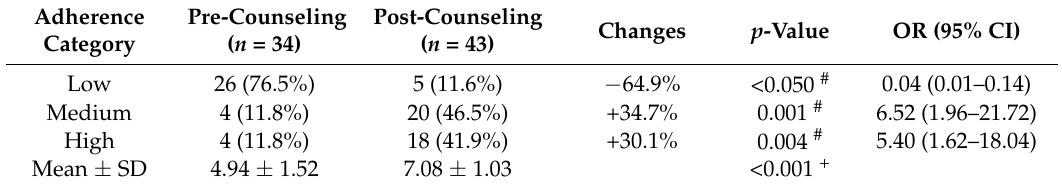
Table 5. Comparison of pre- and post-counseling medication adherence in the intervention group. Adherence